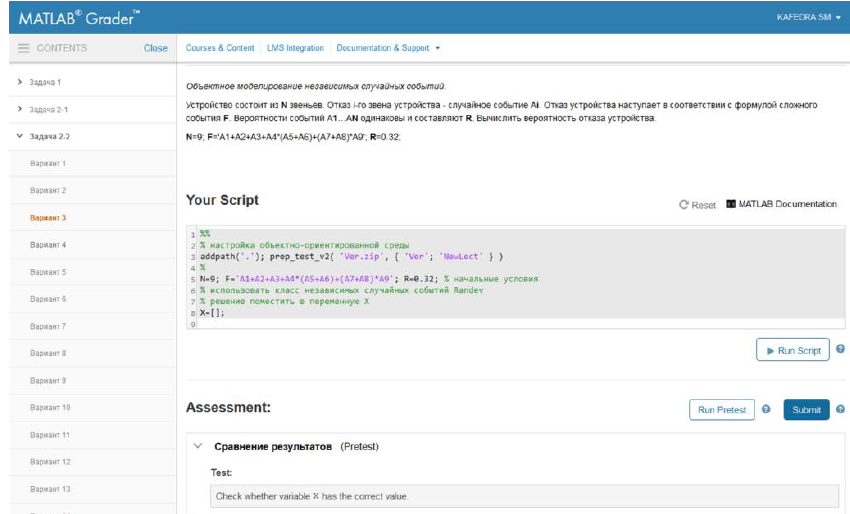
Fig. 3. Interactive study of lectures.